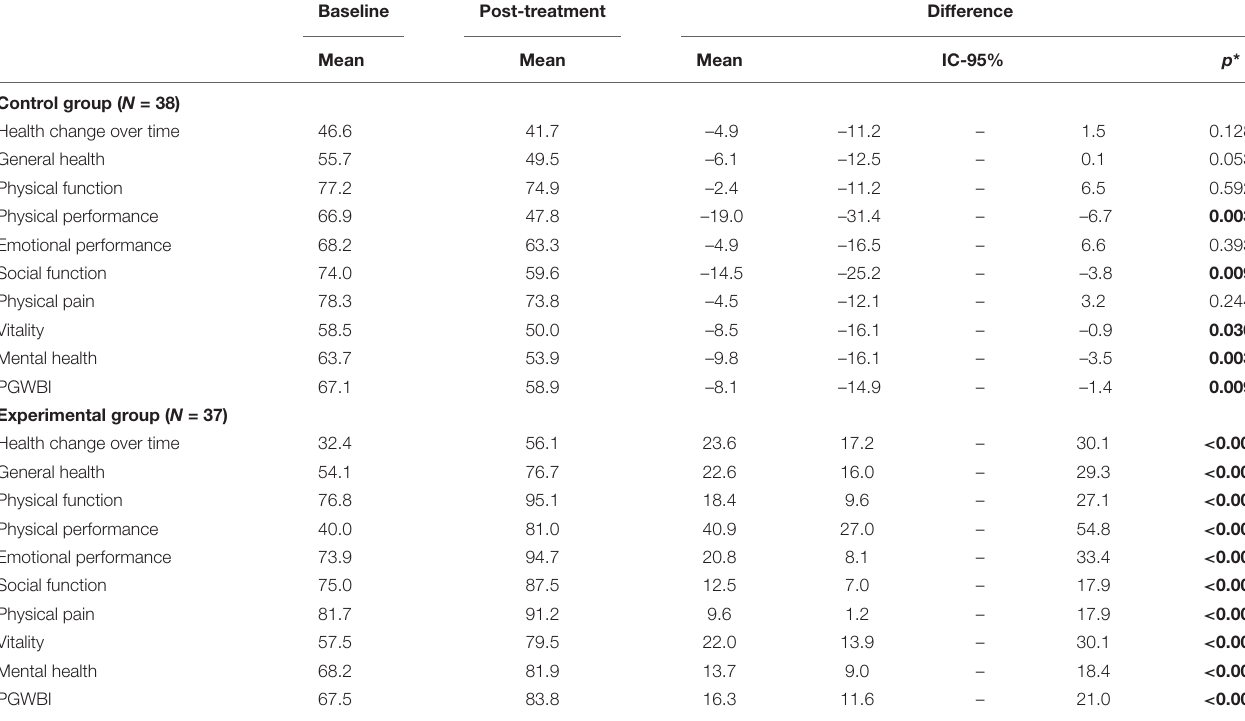
TABLE 4 | Comparative results (posttreatment-baseline) of the dimensions of the SF-36 and PGWBI in the CG and EG. Baseline